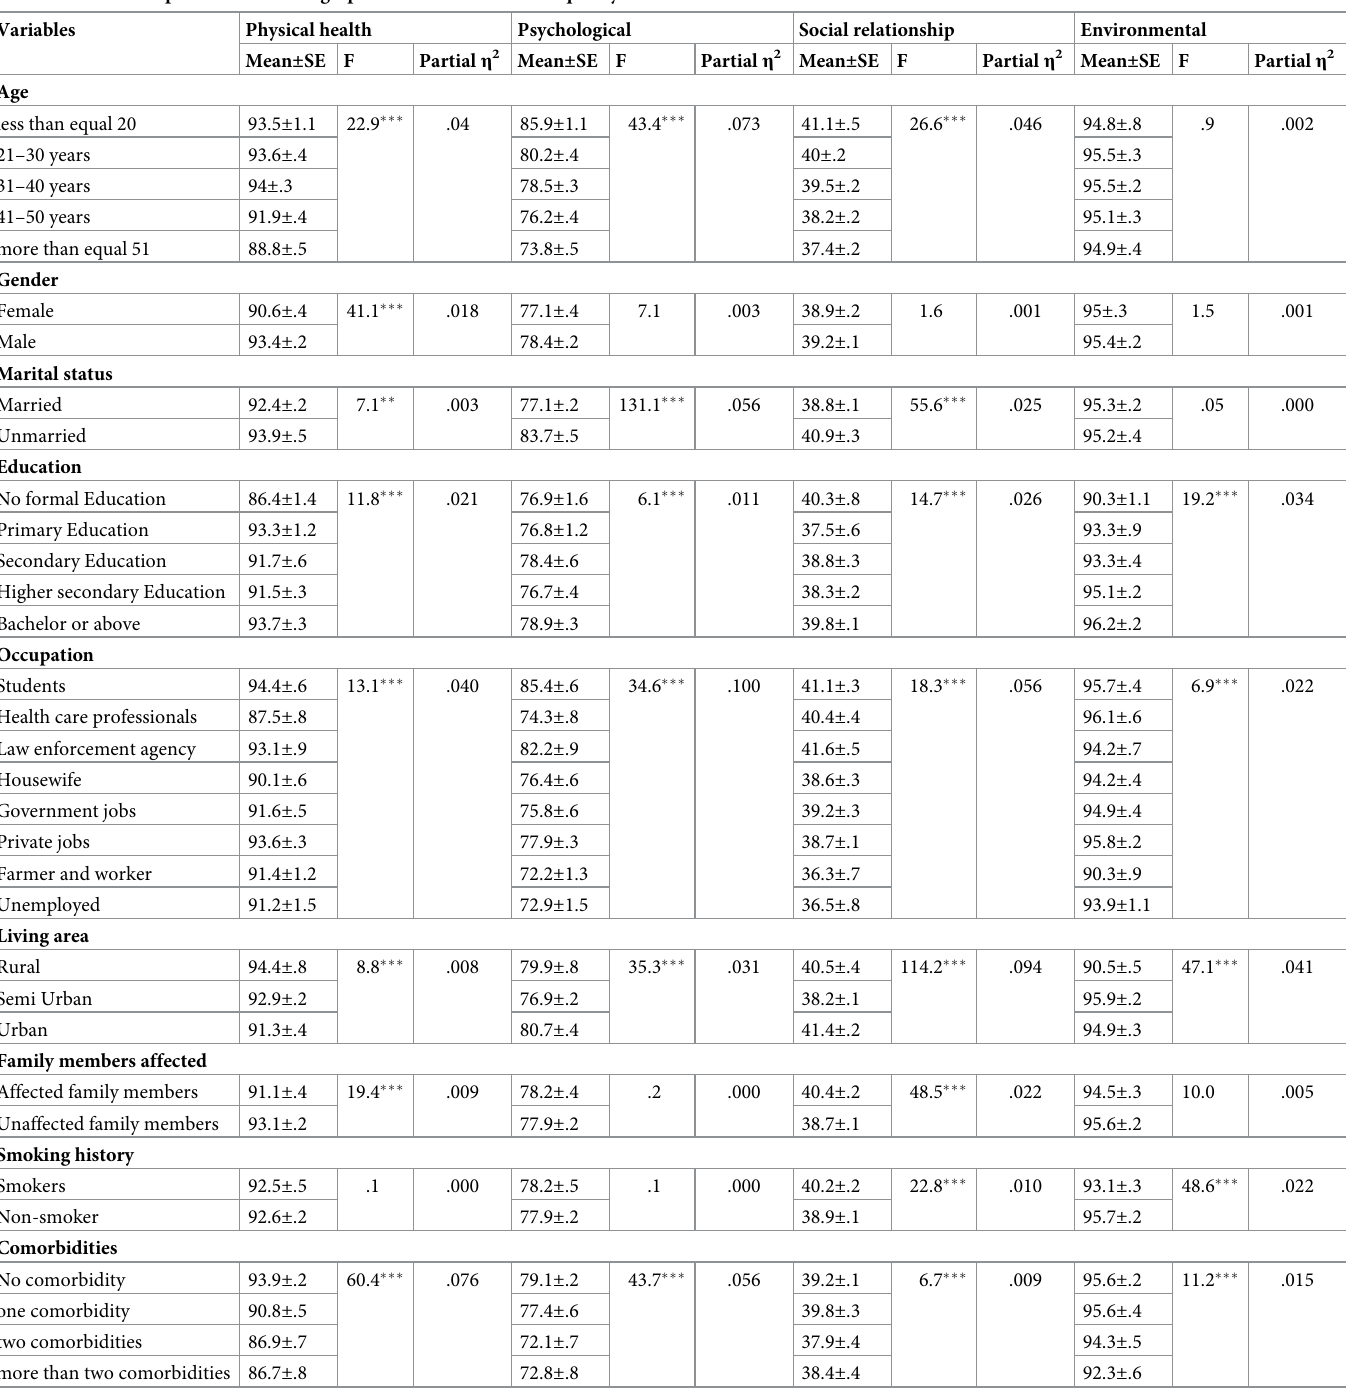
Table 2. Relationship in between demographic variables with WHO quality of